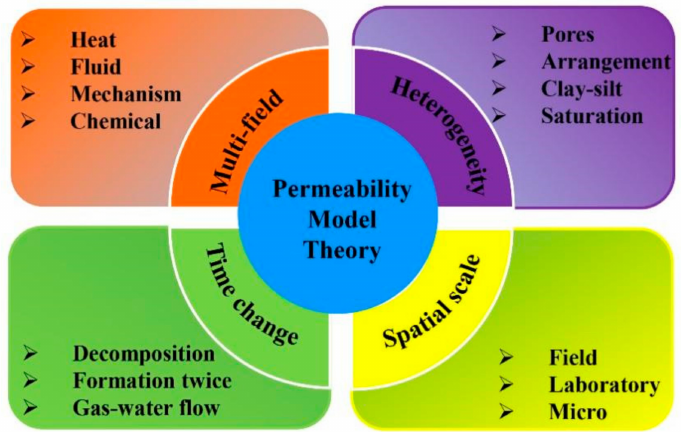
Figure 14. Key points of development in seepage theories in